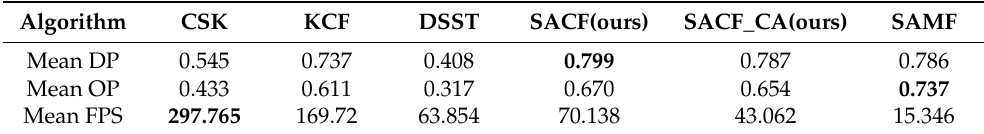
Table 1. Performance comparison of six algorithms.